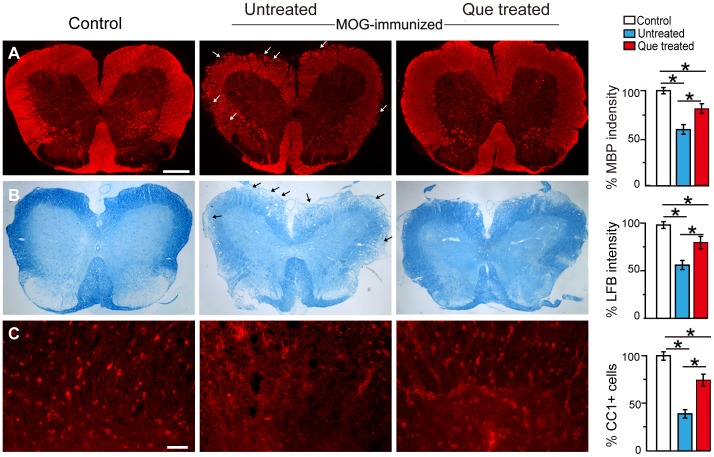
Que protectes the spinal cord from demyelination and loss of oligodendrocytes.
A. MBP immunofluorescent staining displays an obvious decrease of myelin (arrows) in the white matter of the spinal cord in the untreated EAE controls (N = 5). Post-treatment with Que (N = 5) protects myelin from breakdown and displays a similar fluorescence intensity to the unimmunized controls (N = 5). B. Luxol Fast Blue (LFB) staining indicates a similar pattern after Que treatment (arrows). C. Que prevents the loss of CC1+ oligodendrocytes as compared with the untreated controls. Quantification of the observations is provided in the bar graphs. (*, p<0.05). Scale bar A = B = 0.5 mm, C = 0.2mm.